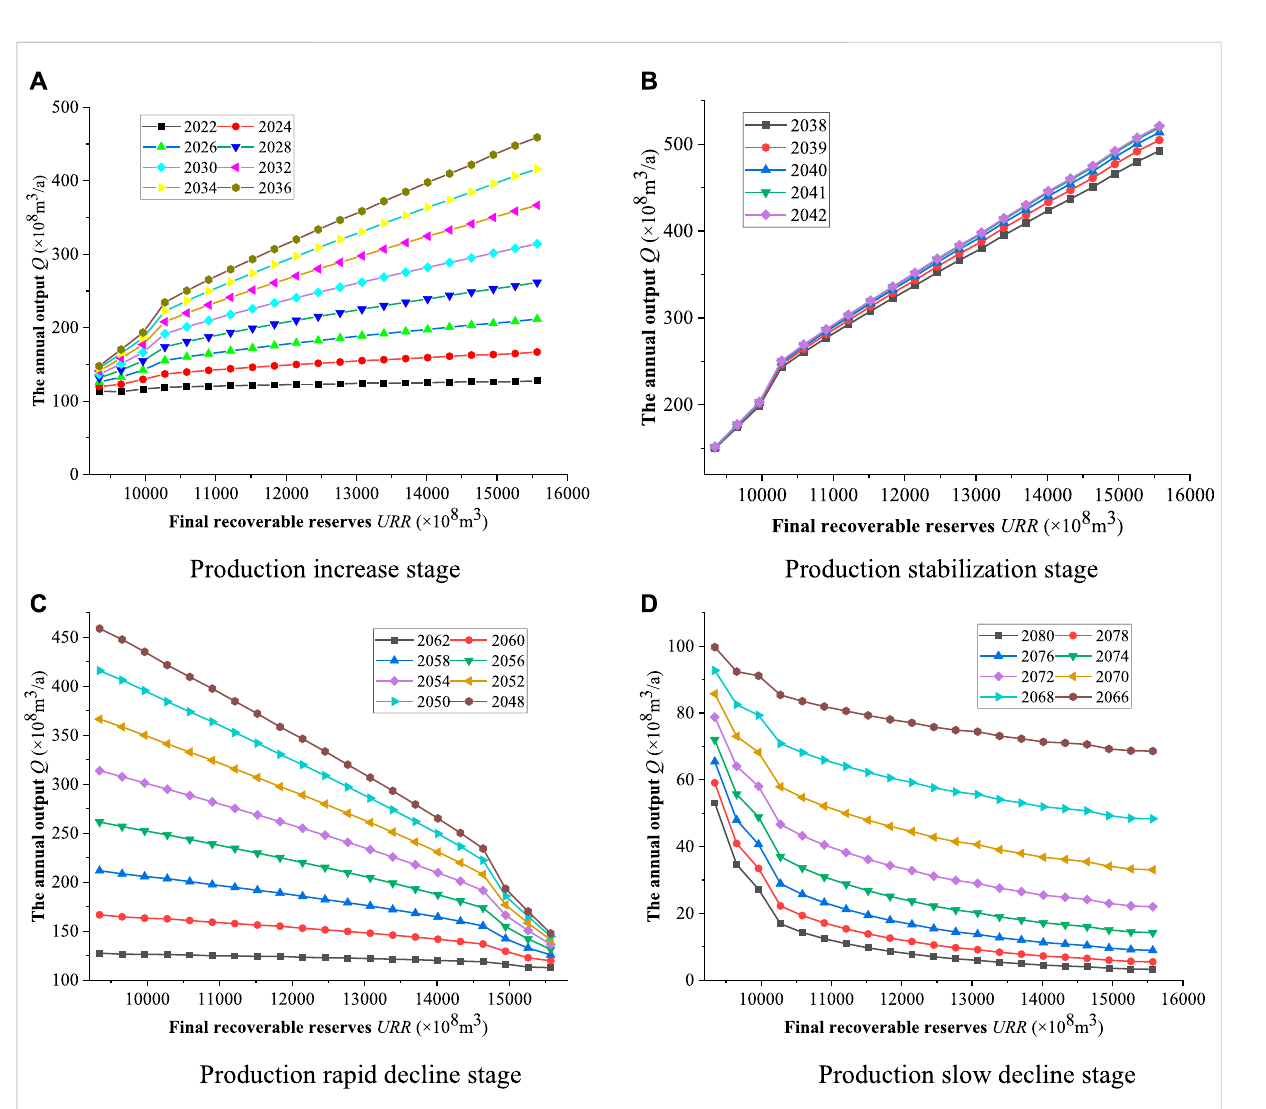
FIGURE 8 YieldpredictionresultsunderdifferentURR. (A) Productionincreasestage. (B) Productionstabilizationstage. (C) Productionrapiddeclinestage. (D) Production slow decline